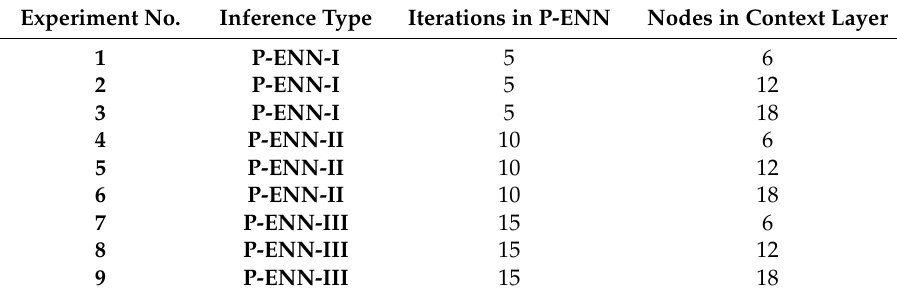
Table 10. The different types of